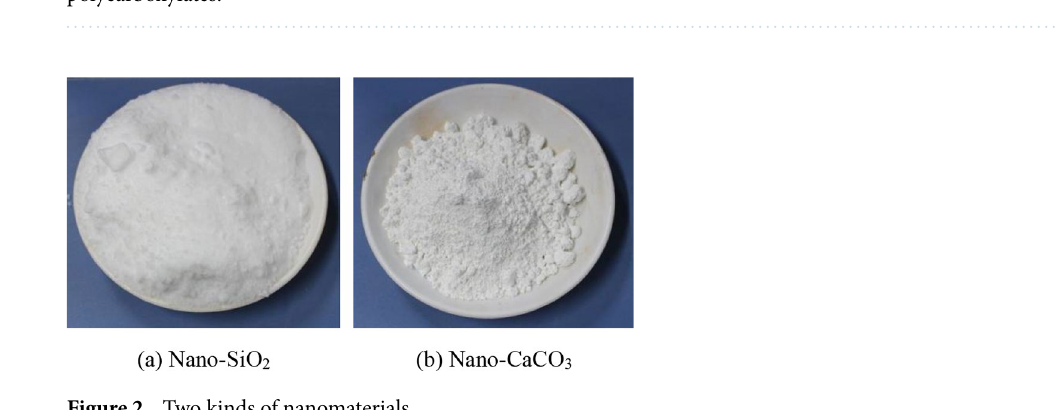
Figure 2. Two kinds of nanomaterials.